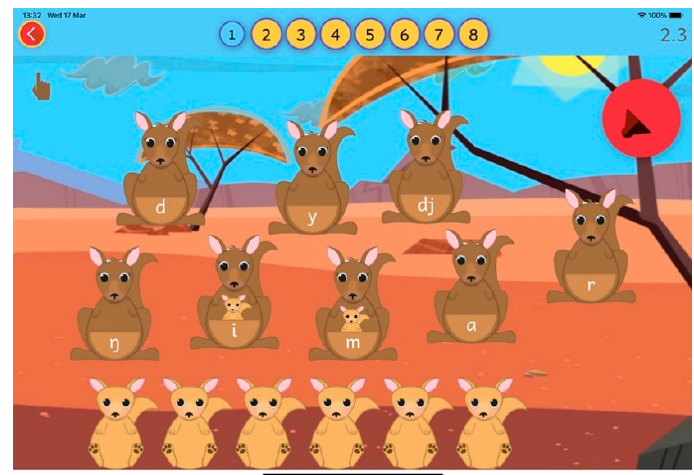
Figure 3. App with variety of picture sources.